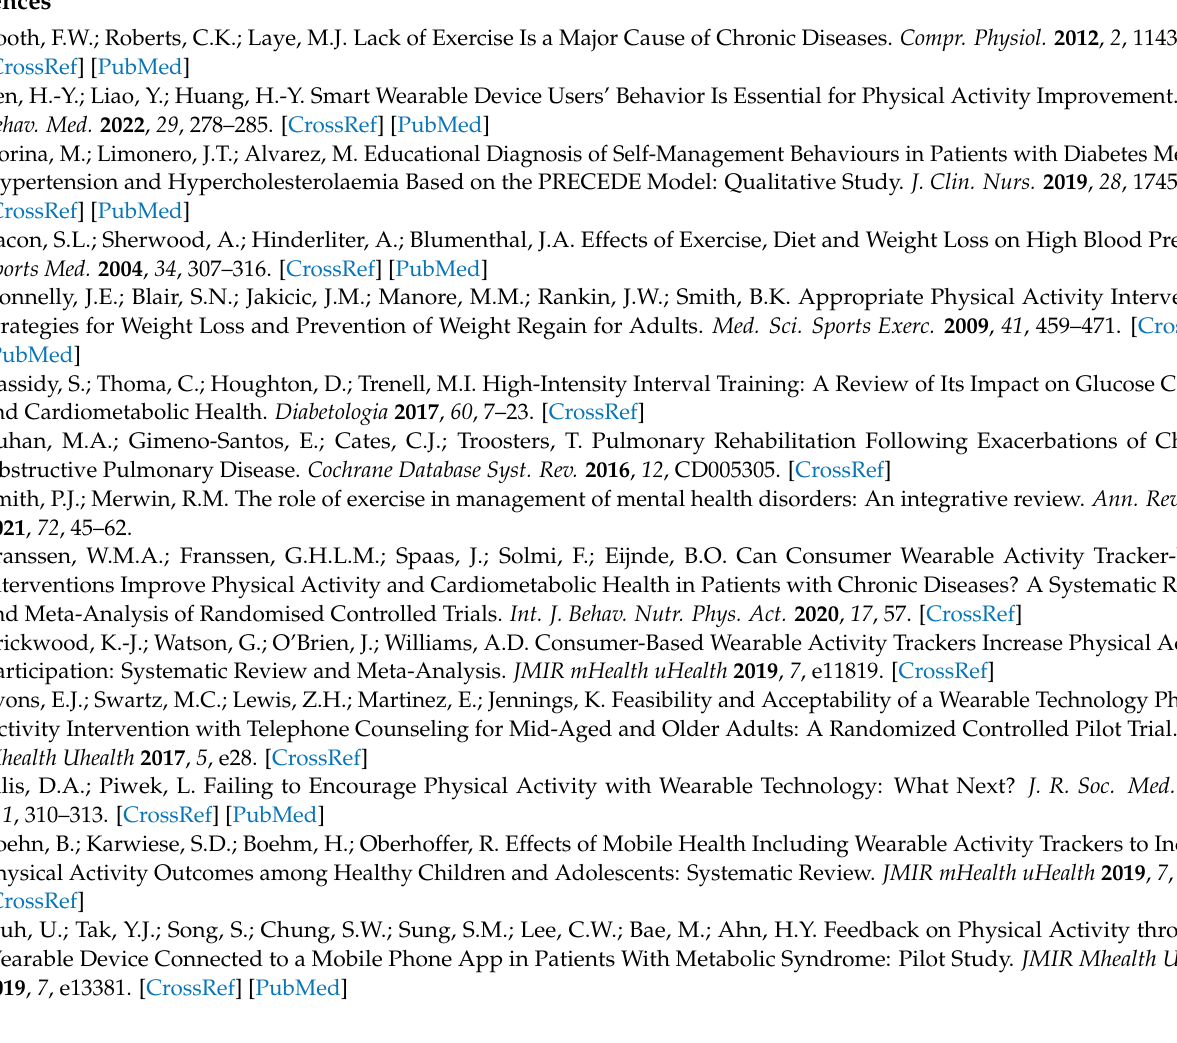
Rows represent the covariates (and their levels); mean treatment and mean control represent the mean effect of the group using wearable devices and the group not using wearable devices; var ratio (Tr/Co) means the ratio of the group using wearable devices to the group of not using wearable devices. For continuous variables, the p -values are taken from the bootstrapped KS-test. For categorical variables, the p -values are taken from the t